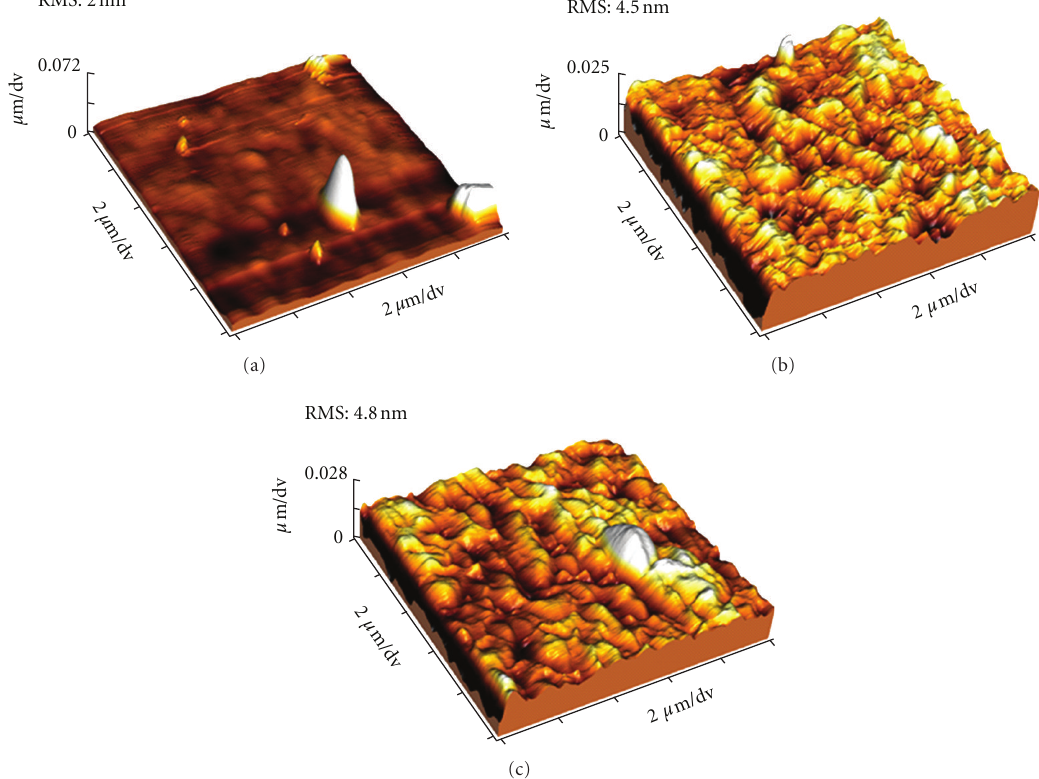
Figure 6: SEM images of the ITO thin films treated (a) without annealing and with annealing at (b) 400 ◦ C and (c) 600 ◦ C in 3% H 2 /97% N 2 mixtures